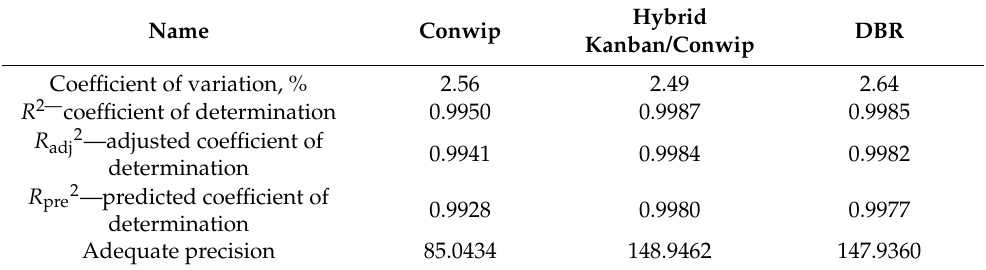
Table 8 represents the regression analysis for Conwip, Hybrid Kanban/Conwip and DBR. The values obtained for the regression functions are given in Table 9. Table 8. Regression analysis—Conwip, Hybrid Kanban/Conwip and DBR.